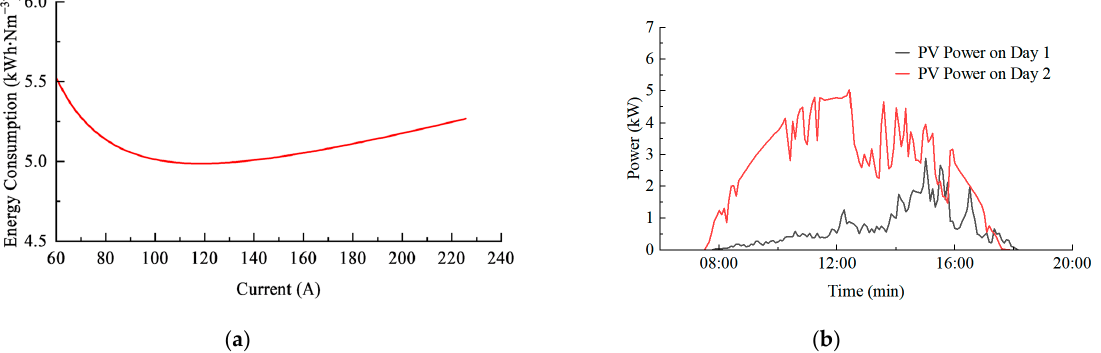
Figure 5. ( a ) Energy consumption under different current density; ( b ) different PV power on differ- ent days.